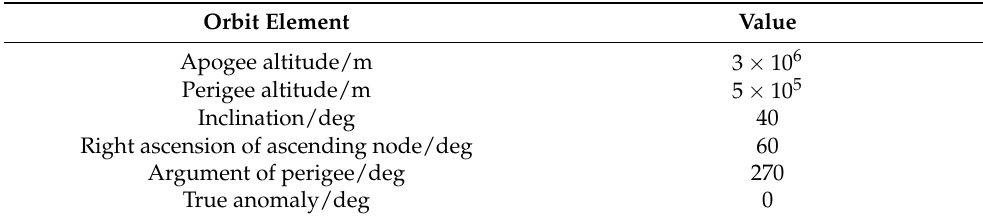
Table 1. Initial orbital elements of the chief